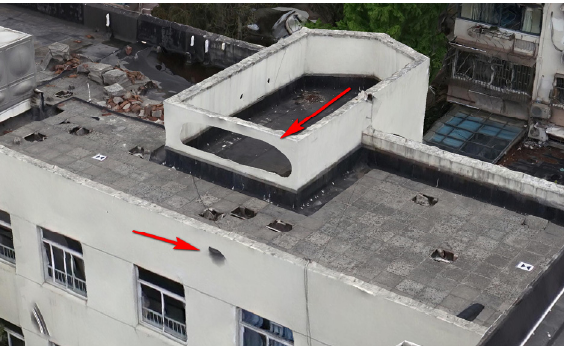
Figure 9. The holes on the wall of the 3D model reconstructed with M600Pro at an altitude of 50 m.